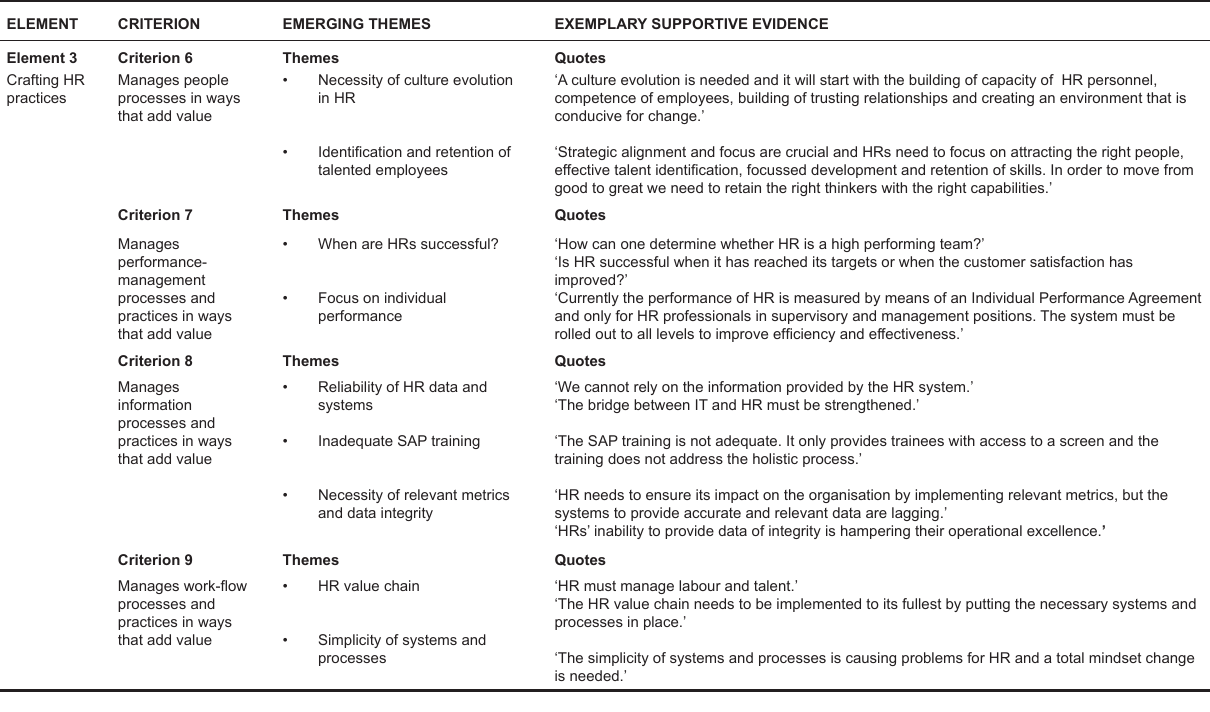
TABLE 4 Emerging themes pertaining to Element 3: Crafting HR practices